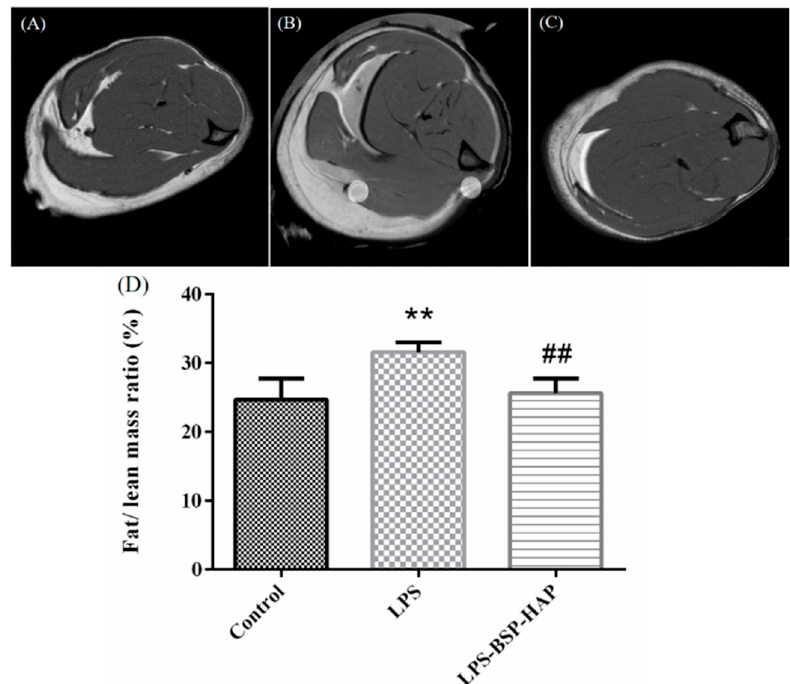
Figure 9. The images from MRI of muscle cross-section ( A ) control group, ( B ) LPS group and ( C ) LPS-BSP-HAP group. The fat and lean mass ratio was calculated by image J ( D ) ( n = 6, ** p < 0.05 compared with control; ## p < 0.05 compared with LPS). The ratio of fat mass to lean mass in the muscles of the control, LPS, and LPS-BSP-HAP groups was 24%, 31%, and 25%, respectively.